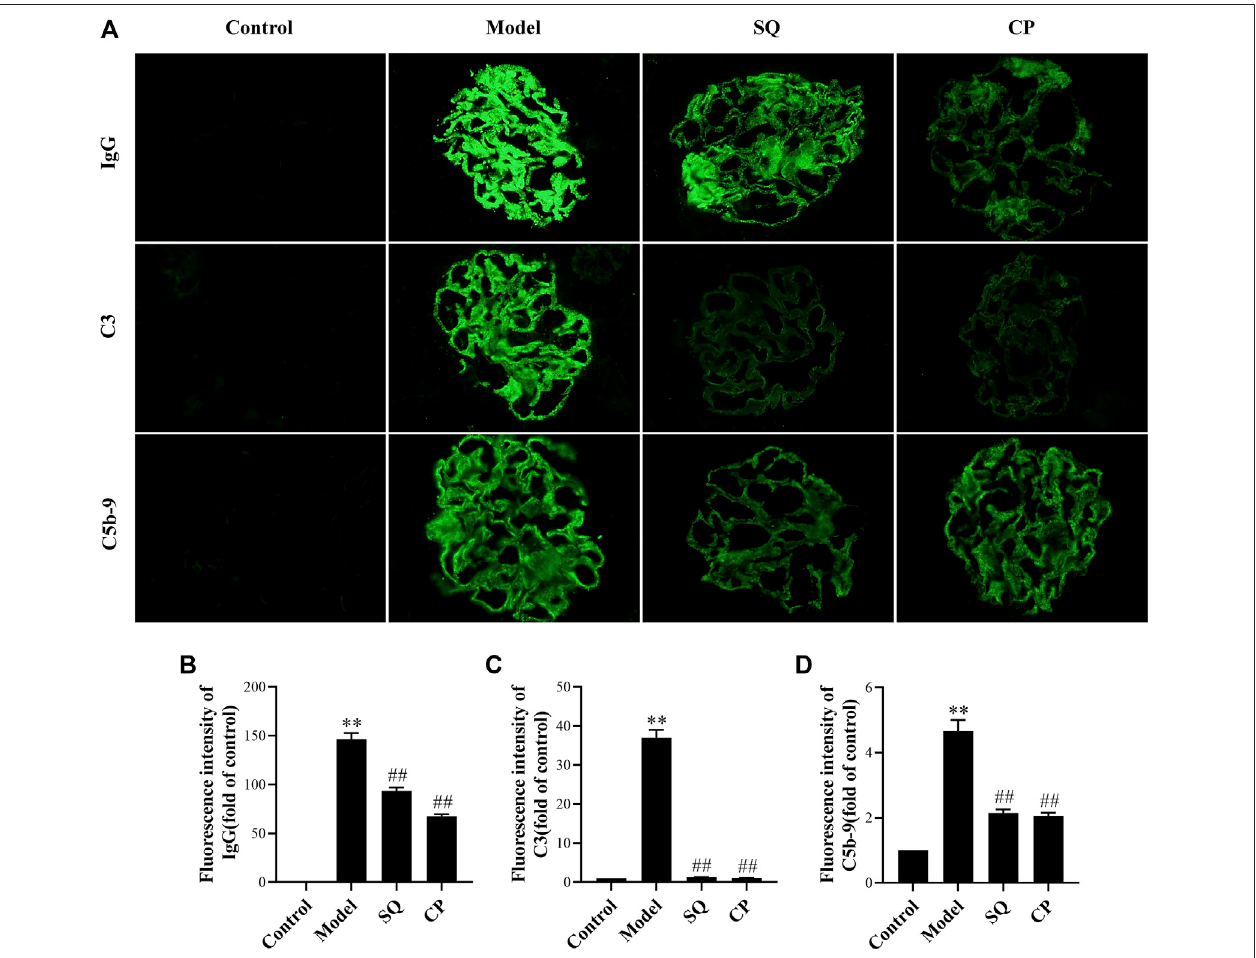
FIGURE 2 | SQ reduced IgG, C3, and C5b-9 deposition in glomeruli of PHN rats (magni fi cation × 400). Kidney cryosections in each group were detected for IgG, C3, and C5b-9 by immuno fl uorescence staining (A) . Quanti fi cation of the fl uorescence intensity of IgG (B) , C3 (C) , and C5b-9 (D) was assessed ( n (cid:1) 6). Data are represented as mean ± SD from independent groups. ** p < 0.01 vs. Control group. ## p < 0.01 vs. Model group.